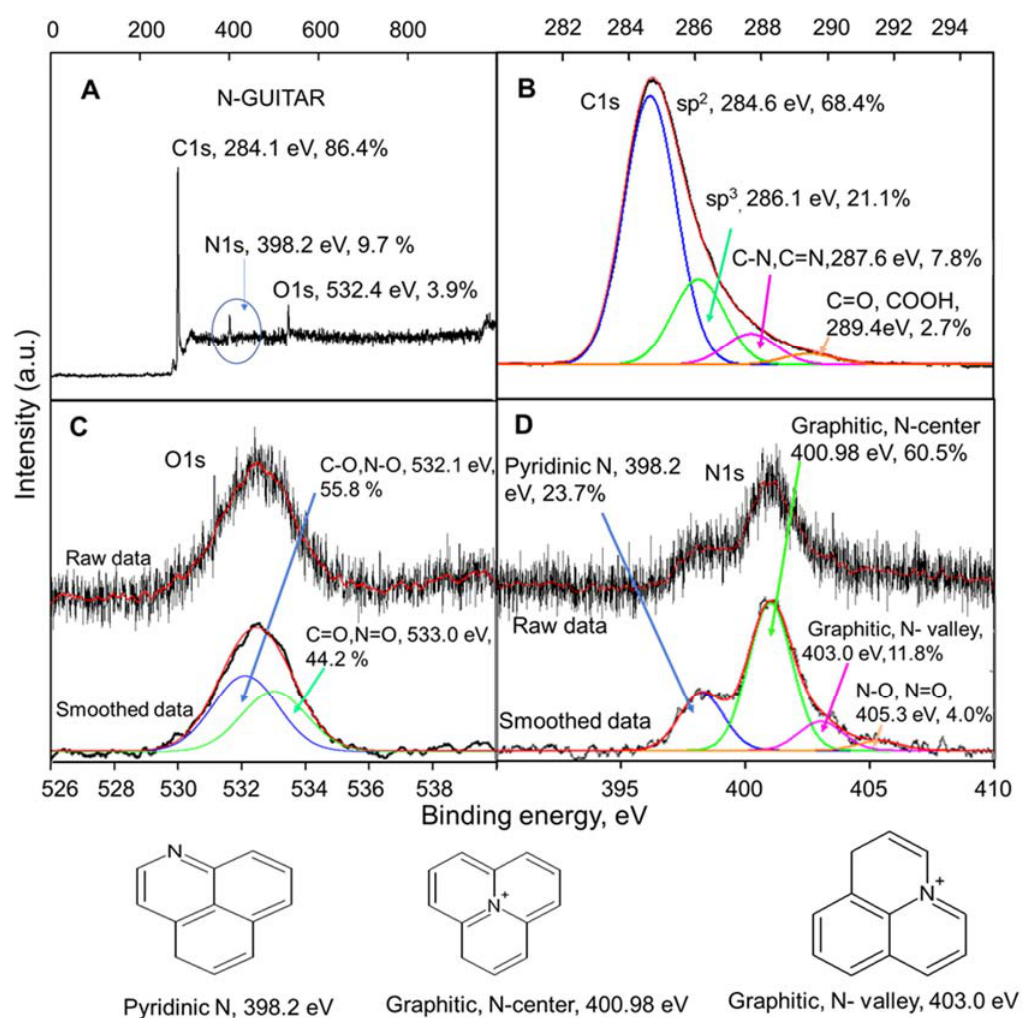
Figure 2. XPS analysis of N-doped pseudo graphite with the respective peak assignments and abundances. ( A ) the wide scan spectrum. The C1s ( B ), O1s ( C ) and N1s ( D ) peaks with deconvolved components. The N1s and O1s spectra are presented with the raw and smoothed data using the Savitzky-Golay method. Experimental data is in black and fitted curves are in red. The structures of the nitrogen species are shown at the bottom.